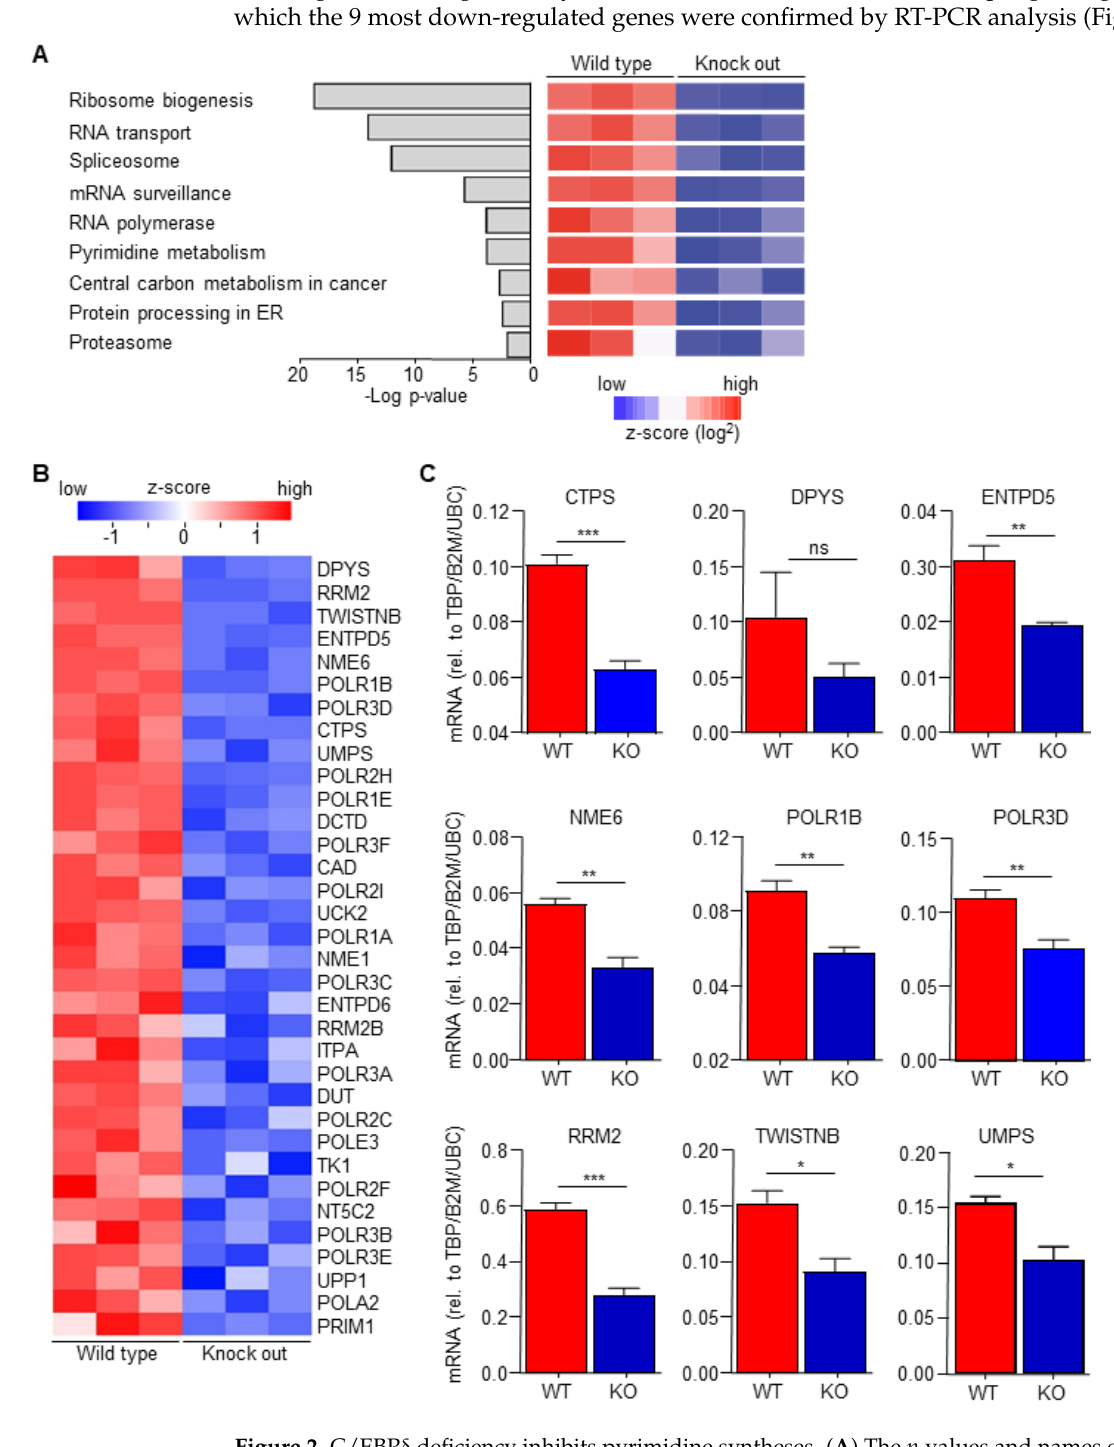
Figure 2. C/EBP δ deficiency inhibits pyrimidine syntheses. ( A ) The p -values and names of the most over-represented KEGG pathways, calculated on the basis of all the differentially expressed genes between wild type and C/EBP δ -deficient macrophages. ( B ) Heatmap of all the differentially expressed genes from the pyrimidine metabolism pathway. ( C ) RT-PCR validation of the top differentially expressed genes of the pyrimidine metabolism pathway. * p < 0.05; ** p < 0.01; *** p < 0.005; ns: not significant.